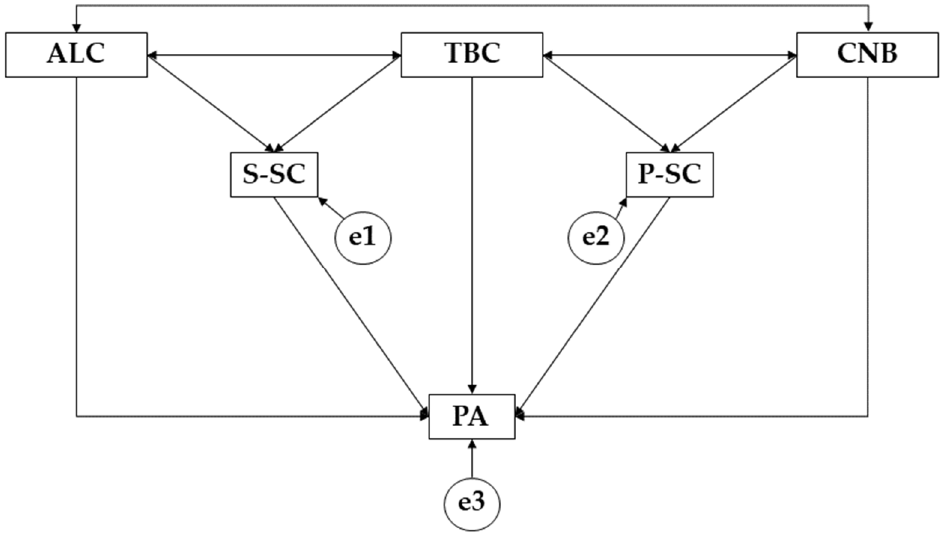
Figure 1. Structural equation model. Note: alcohol (ALC); tobacco (TBC); cannabis (CNB); social self-concept (S-SC); physical self-concept (P-SC); physical activity